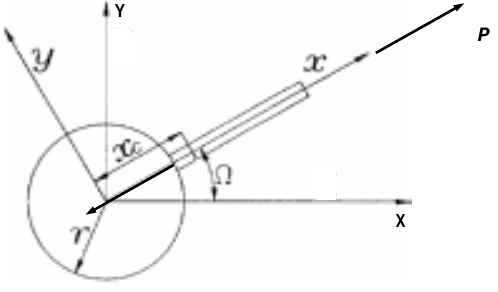
Fig. 1. Coordinate system of the rotating